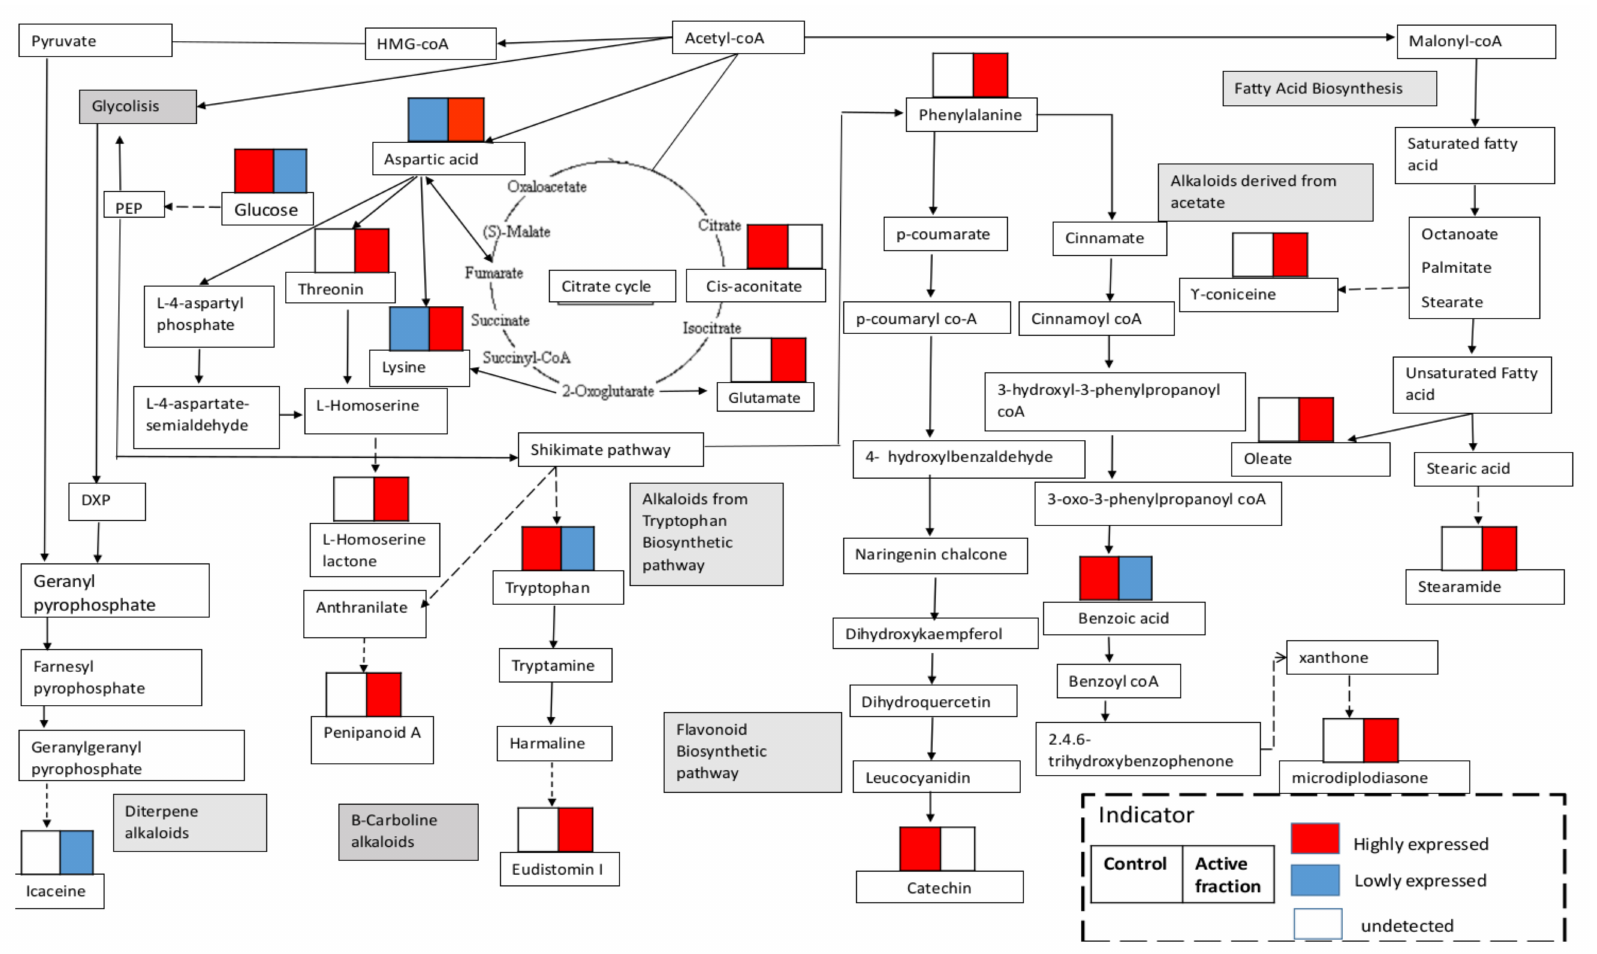
Figure 7. Metabolites involved in the biosynthetic pathway of G. boninense–S. parasiticum interactions. Single arrows represent one-step enzymatic conversions, while dashed arrows represent multiple